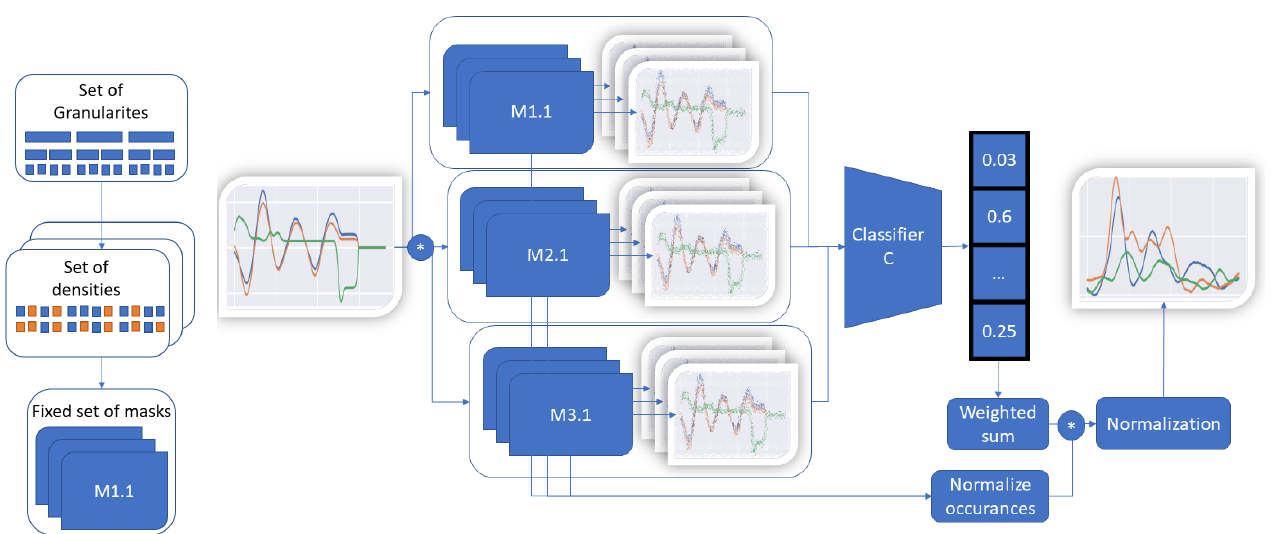
Figure 1. TimeREISE. Shows the two steps required to use TimeREISE. ( a ) shows the generation based on a set of different granularities and densities. The granulariy defines the number of slices and the density of the number of perturbed slices within a mask. ( b ) shows a set of masks (M1.1 to M3.x) applied to the input using an exchangeable perturbation function. The default perturbation is an element.wise multiplication. The masked input is passed to a classifier and the classification score is retrieved. The classification score is multiplied (*) by the masks and normalized by the number of feature occurrences. Finally, the attribution is normalized based on the number of occurrences of each